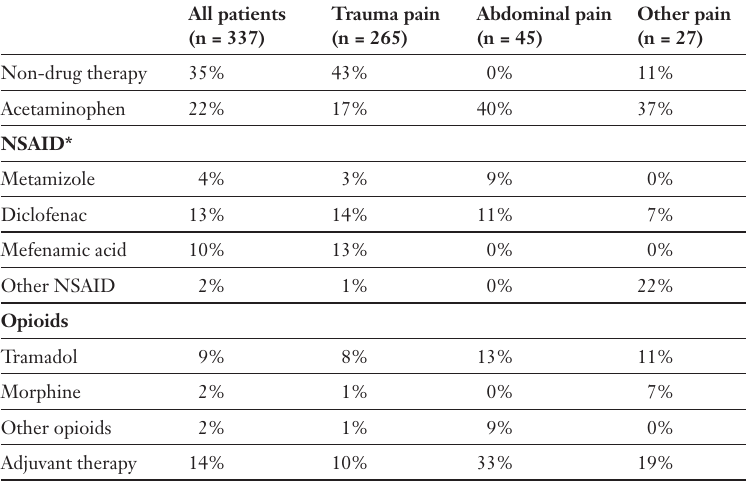
Adherence to pain management protocols at the time of initial evaluation (subgroups).